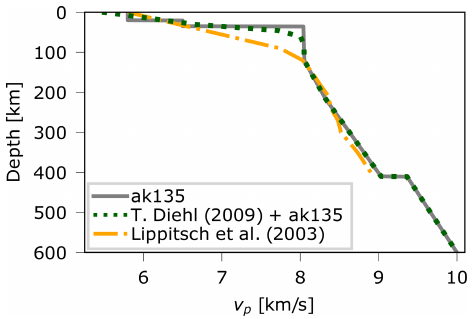
Figure 4. Dotted line: one-dimensional model used in this study as initial model for the inversion in regions beyond the extent of the a priori crustal model. For comparison, the standard earth model AK135 (solid line) and the reference model used by Lippitsch et al. (2003) (dashed–dotted